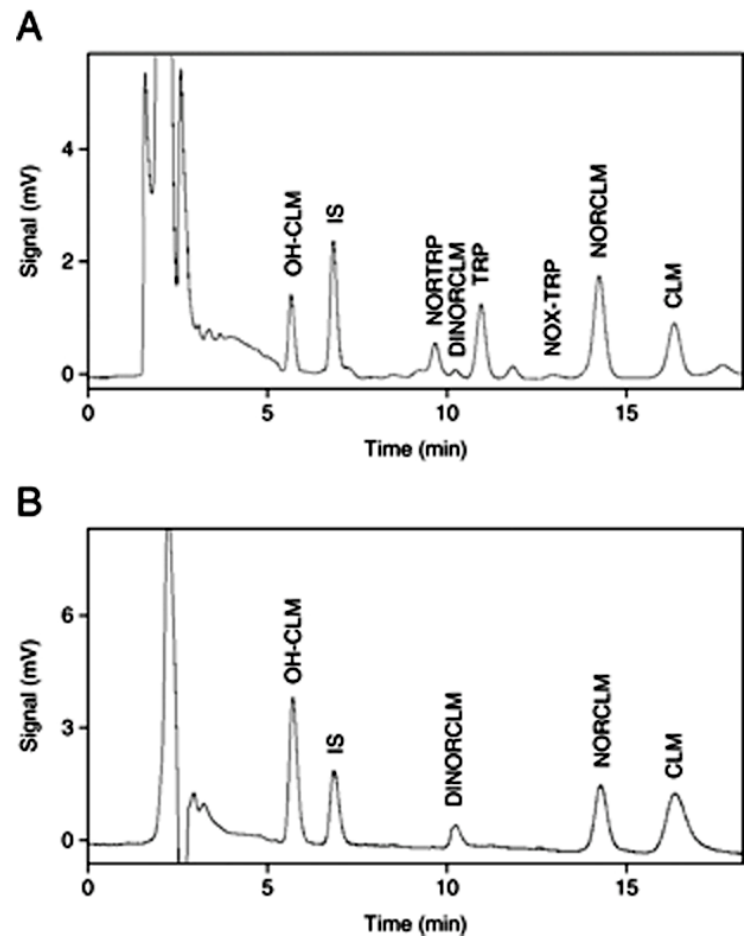
Figure 9. Chromatograms of plasma samples from patients subjected to therapy with tricyclic antidepressants. Stationary phase: C8 column (150 × 4.6 mm particle size (id), 5 μm); mobile phase: ACN/pH 3.0, 50 mM phosphate buffer (32:68 v/v ); flow rate: 1 mL/min; detection: 220 nm; loop: 50 μL